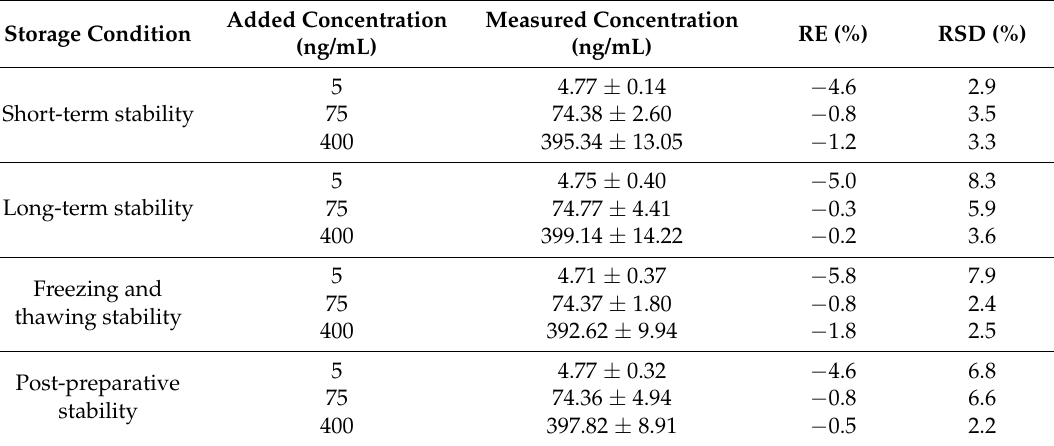
Table 3. Results of stability of yuanhuacine in rat plasma ( n =